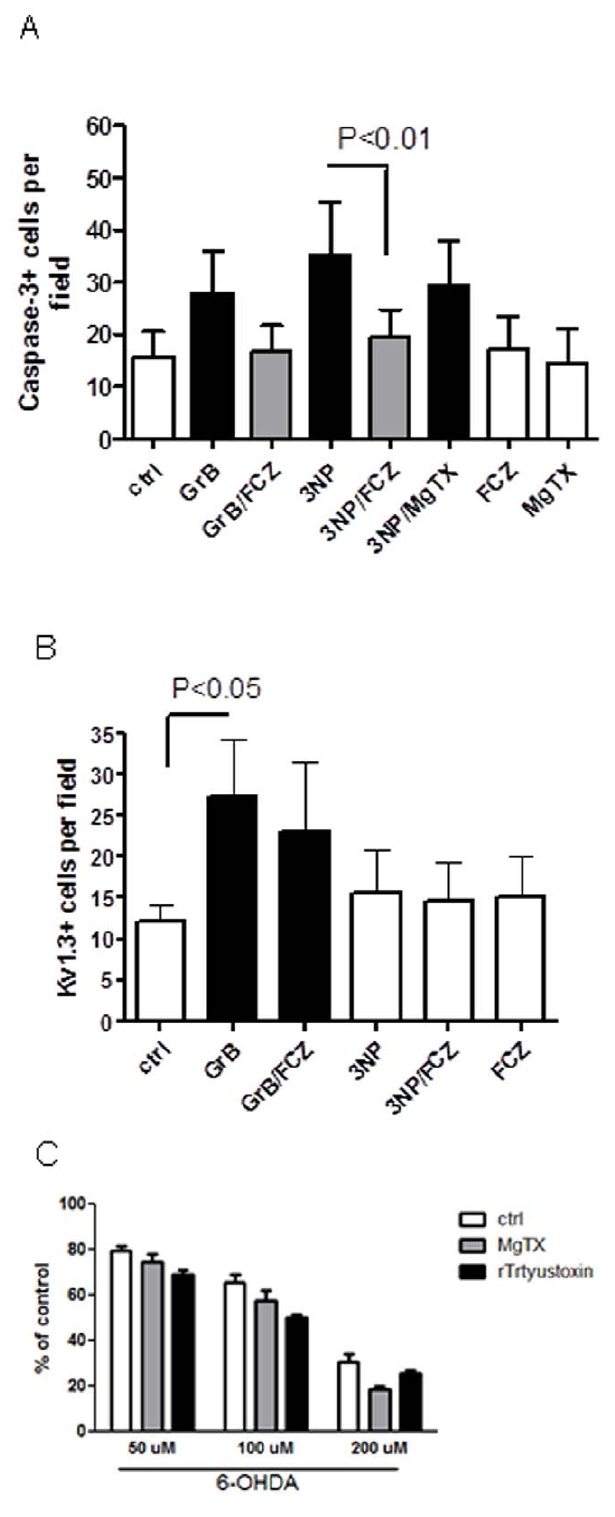
Figure 6. Kv1.3 activation is specific to GrB-mediated neuro- toxicity. A. Human neuronal cultures were treated with GrB (4 nM) and mitochondrial inhibitor 3NP (3 mM) with/without 30 min of pretreat- ment of MgTX (10 nM) or fluconazole (FCZ, 10 m M). After 24 hr, cells were collected and fixed. Duplicate coverslips from each treatment were immunostained for active caspase-3 and Kv1.3. Positive cells in each of nine predesigned fields were counted. Average of positive cells